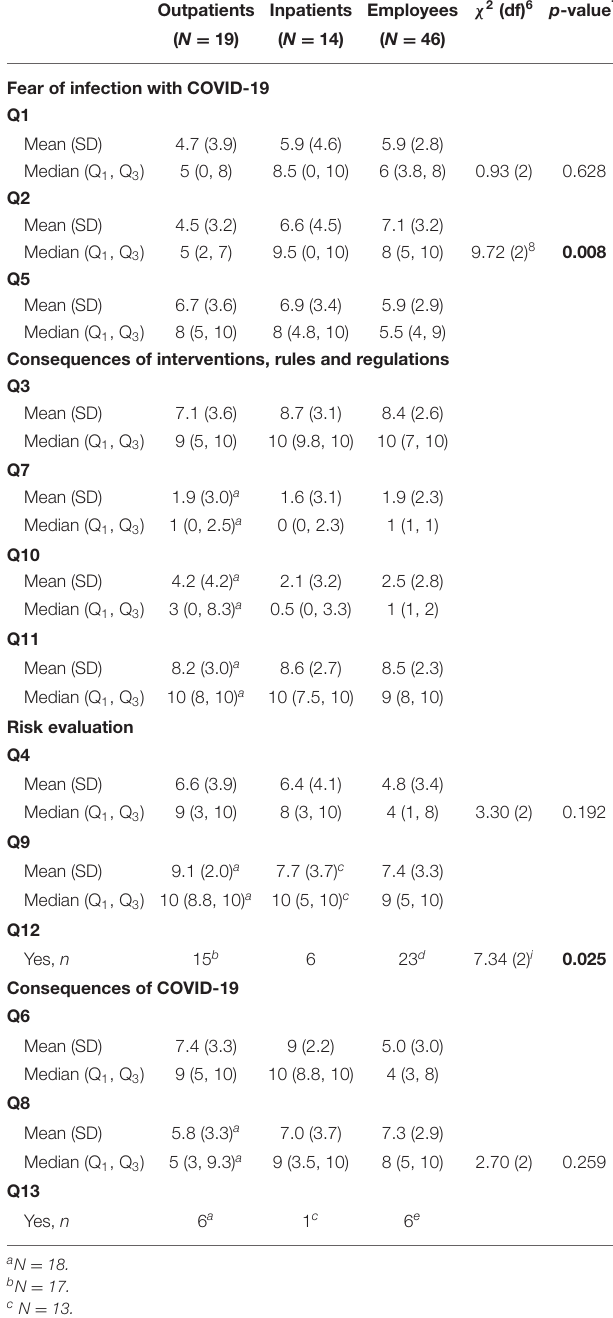
TABLE 2 | Descriptive statistics for questions within